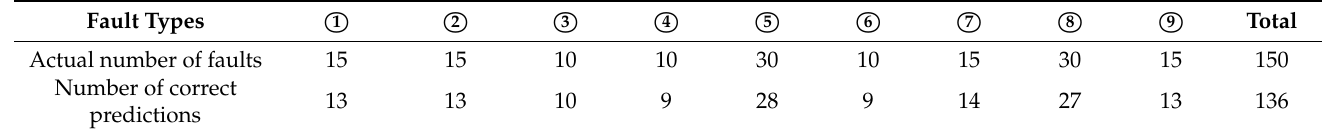
Table 11. Number of correct fault predictions for the first set of data.